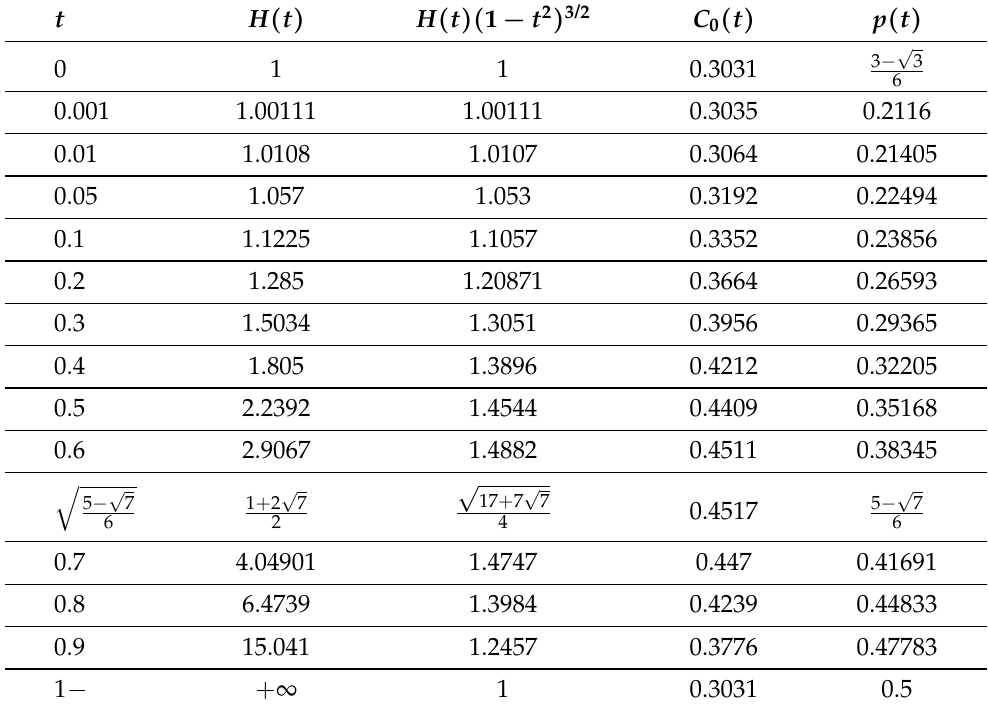
Table 1. The values of the functions H ( t ) , H ( t )( 1 − t 2 ) 3/2 , C 0 ( t ) = 0.3031 · H ( t )( 1 − t 2 ) 3/2 , and the mass p ( t ) of one of the atoms of the extreme distribution rounded up, for some t ∈ [ 0,1 )